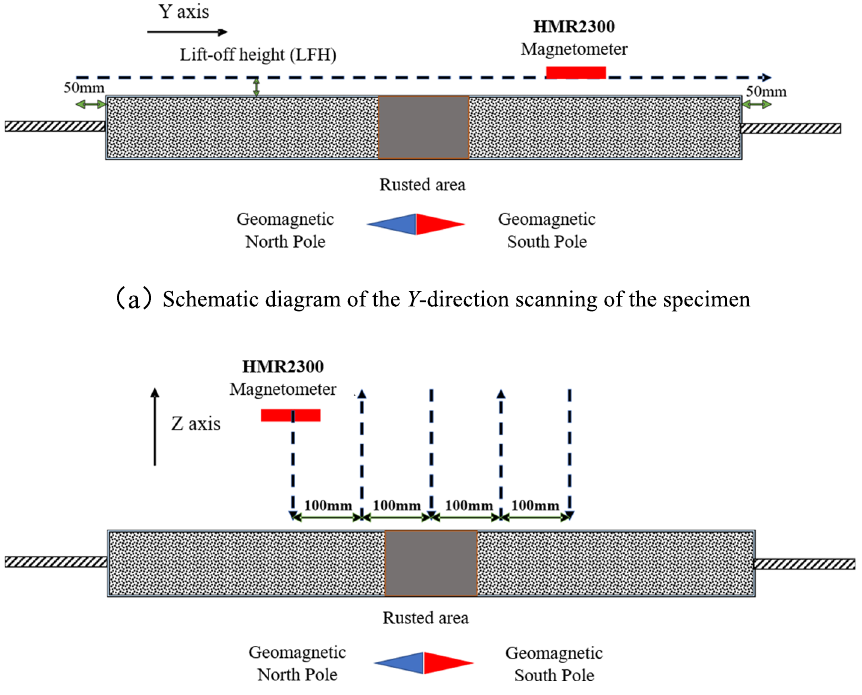
Fig. 5 Schematic diagram of magnetic flux leakage signal scanning of reinforced concrete structure specimen. a Schematic diagram of the Y -direction scanning of the specimen. b Schematic diagram of the Z -direction scanning of the specimen